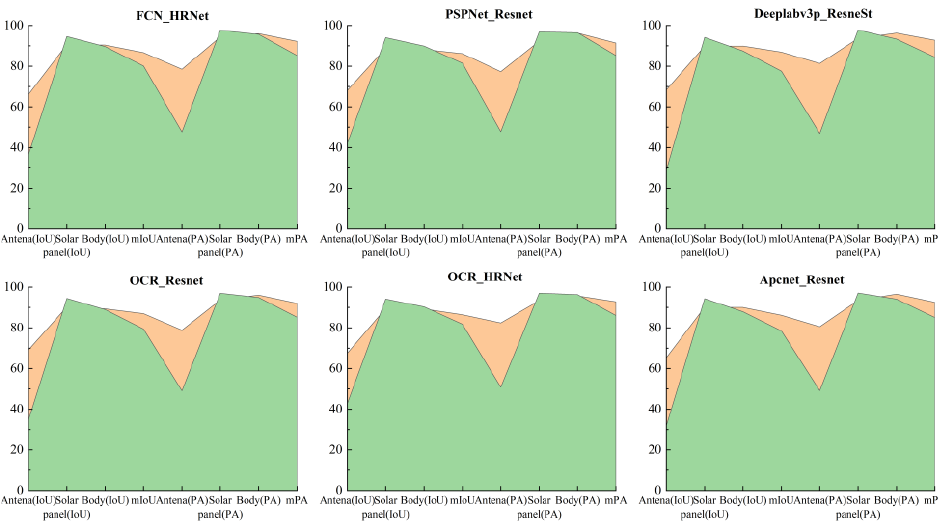
Figure 13. Comparison of validation accuracy of training results in spacecraft dataset and real-shot validation dataset. The green upper boundary is the validation accuracy of the real-shot validation dataset, and the yellow upper boundary is the validation accuracy of spacecraft dataset.